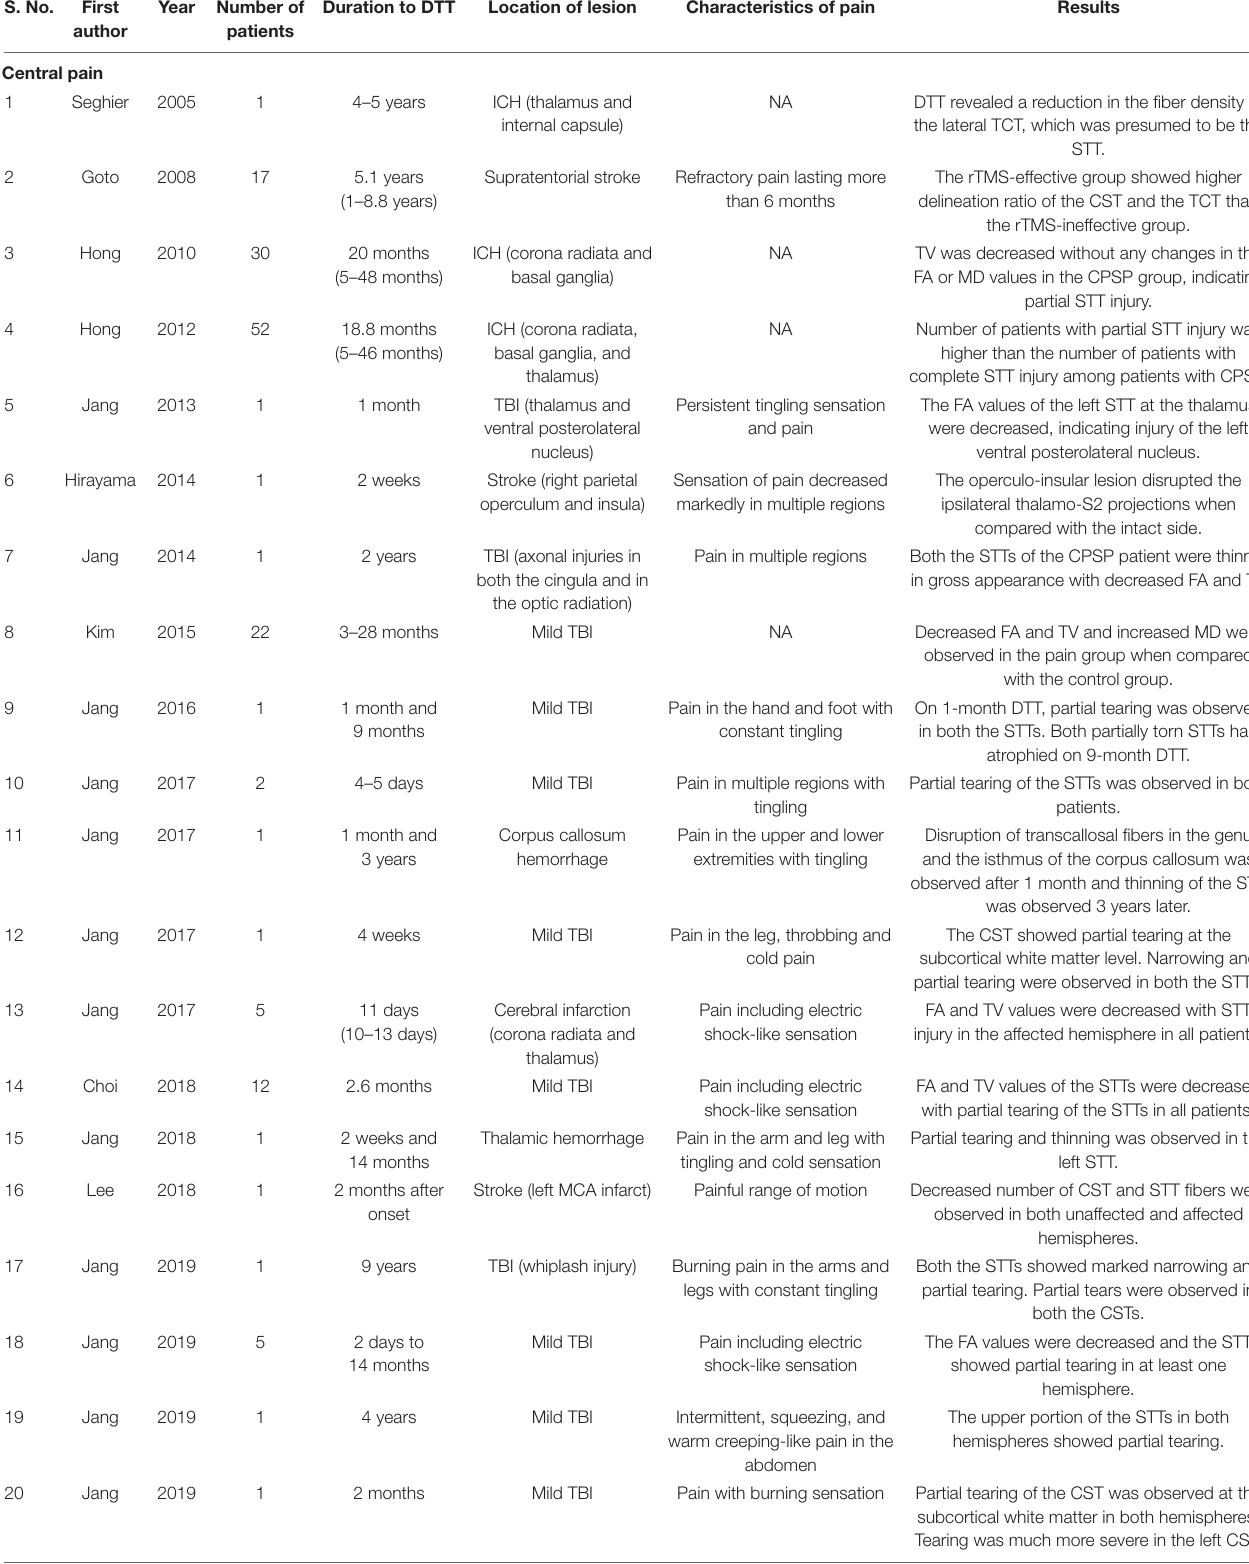
TABLE 1 | Characteristics of the included